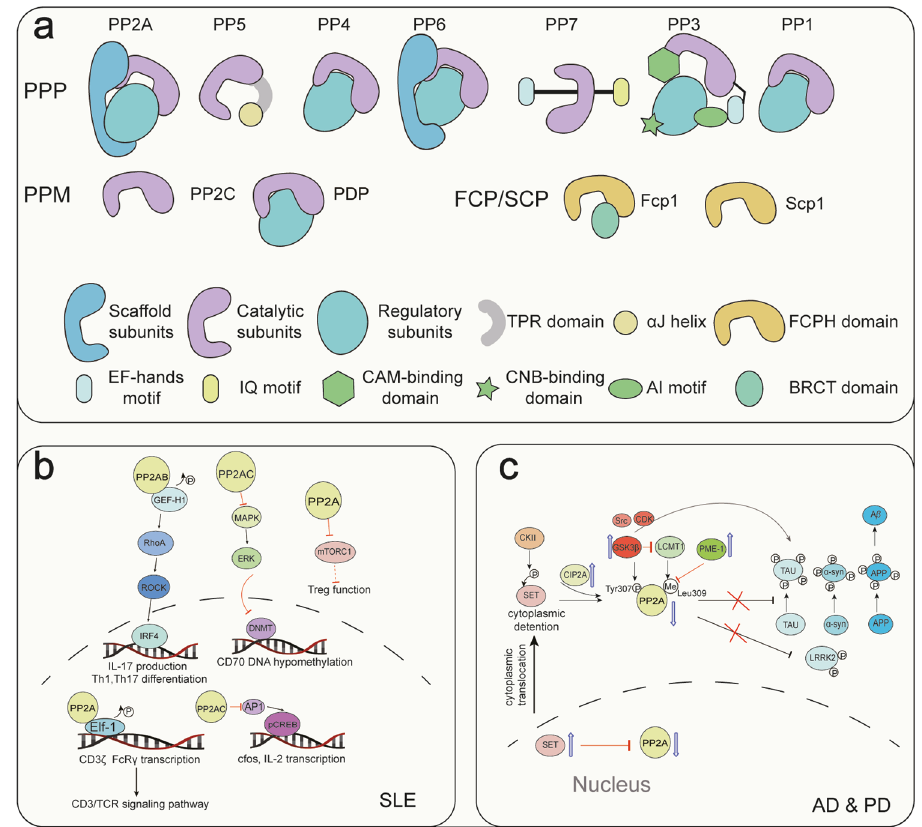
Fig. 3 The PSP family and the regulated signaling pathways of PP2A in systemic lupus erythematosus (SLE), Alzheimer ’ s disease (AD), and Parkinson ’ s disease (PD). a Representative holoenzymes of 3 PSP families. The PPP family contains 7 subfamilies: PP1, PP2A, PP3, PP4, PP5, PP6, and PP7. The catalytic subunits are conserved. PP5 and PP7 work in monomeric enzyme form, while others work in holoenzyme form with the help of catalytic subunits, regulatory subunits, and/or scaffold subunits. The PPM family contains PP2C and PDP. PP2C works in monomeric enzyme form, and PDP works as heterodimer that consists of a regulatory and a catalytic subunit. FCP/SCPs have a conserved structural core of the FCPH domain. b The role of PP2A and its subunits in regulating immune cell differentiation and activation through major signaling pathways in SLE. The aberrant expression of different subunits of PP2A in SLE results in the activation of CD3 T cells, differentiation of Th1 and Th17 cells, and inhibition of Tregs. c The effects of PP2A on the accumulation of Tau, α -syn, and A β protein in AD and PD. In neurodegenerative conditions, nuclear pores start to leak, and SET is translocated to the cytoplasm. It then freely diffuses between the nucleus and cytoplasm, but phosphorylation of SET by CKII (casein kinase II) causes its retention in the cytoplasm. Together with an increased activity of GSK3 β in the cytoplasm, the consequence is an increased tau phosphorylation, as indicated. PPP phosphoprotein phosphatases, PDP pyruvate dehydrogenase phosphatase, FCP TFIIF-associating component of RNA polymerase II CTD phosphatase, SCP small CTD phosphatase, APP amyloid- β precursor protein. TPR domain the tetratricopeptide repeat domain, FCPH domain FCP-homology domain, CAM- binding motif calmodulin binding motif, IQ motif calmodulin binding motif in PP7, CNB-binding motif calcineurin B binding motif, AI motif autoinhibitory motif, BRCT domain BRCA1 C-terminal domain like domain may be attributed to its inhibitory action on IL-4 mediated JAK1/ STAT6 activation. SHP2 in alveoli epithelia has also been shown to mediate the expression of thyroid transcription factor 1 and ATP- binding cassette subfamily A member 3, which regulate surfactant protein expression during alveolar homeostasis. SHP2 also activated fi broblast growth factor (FGF)/ Grb2-associated binder family proteins (Gab)/ERK signaling, which is required for the lung epithelial repair program. 61 Bleomycin-induced lung fi brosis tissues also showed a marked activation of SHP2, STAT3, and suppressor of cytokine signaling 3 that was highly associated with pulmonary parenchymal lesions and collagen deposition. Blocking STAT3 or SHP2 improved the anti fi brotic ef fi cacy of IFN- γ . 56 SHP2 also activated NF- κ B and macrophage polarization in the in fl ammation model during pulmonary infection. 62 The results of cigarette smoke-induced chronic obstructive pulmonary disease models showed that exposure of mouse lungs or pulmonary epithelial cells to a cigarette smoke extract resulted in elevated levels of SHP2 with increased levels of IL-8, a proin fl ammatory cytokine, and lung in fl ammation via activation of Epidermal growth Signal Transduction and Targeted Therapy (2022)